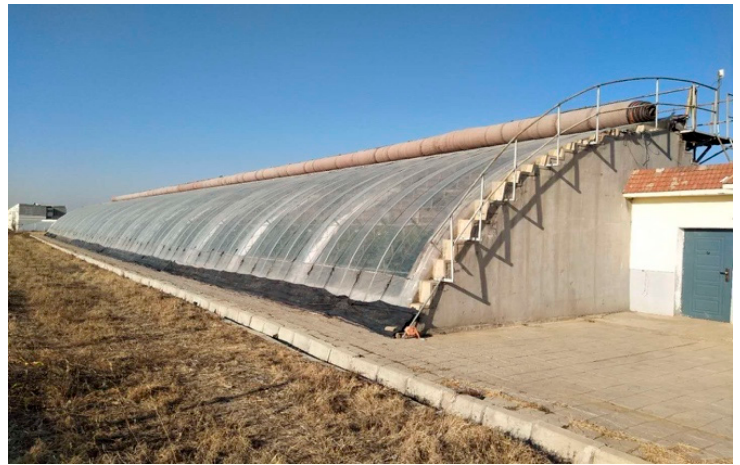
Figure 1. Exterior appearance of the Chinese solar greenhouse used in the experiment.